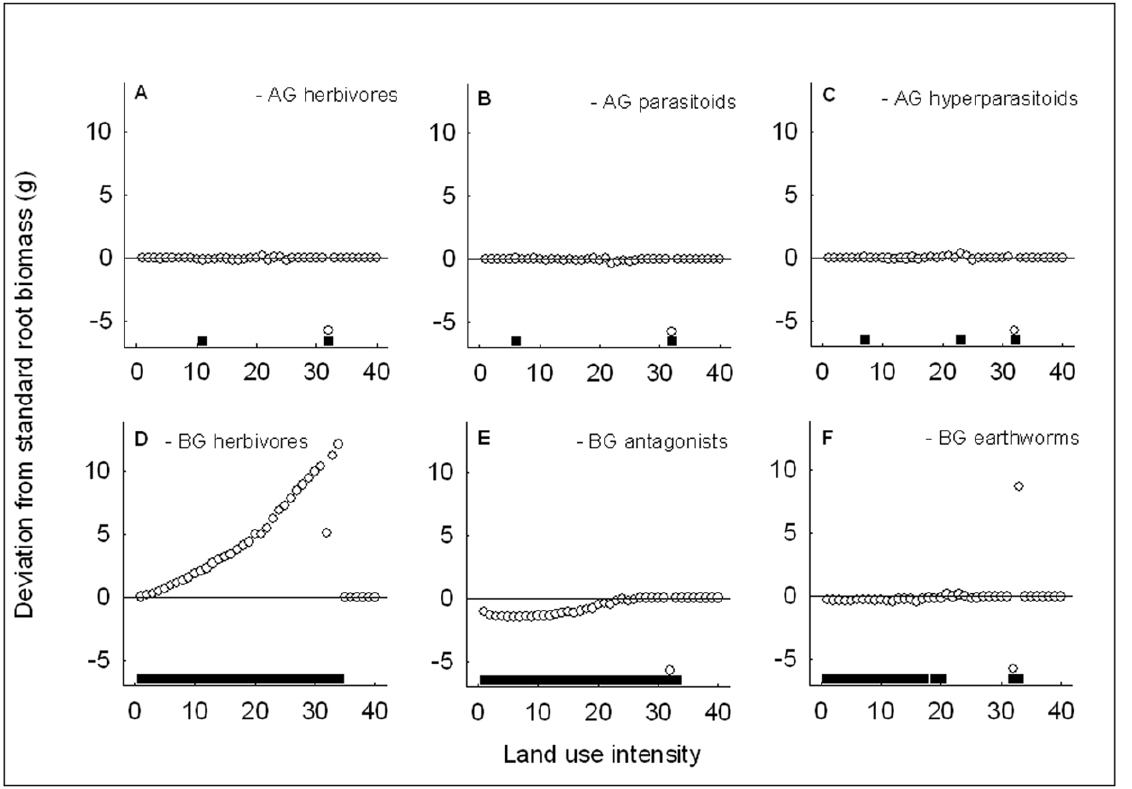
Figure 5. Root biomass and multitrophic interactions with increasing land use intensity. Deviation from median root biomass in the standard scenario from low to high land use intensity after removal of aboveground (top row) and belowground (bottom row) trophic levels and earthworms, i.e. removal of aboveground (a) herbivores, (b) parasitoids, or (c) hyperparasitoids, or belowground (d) herbivores, (e) antagonists, or (f) earthworms. AG – aboveground, BG – belowground. The horizontal line at 0.0 represents the values of the standard scenario. Points indicate the difference in root biomass between the respective removal scenario and standard scenario, and horizontal bars at the bottom of each graph indicate for each of the 40 points whether this difference is significant based on the Mann-Whitney U -test ( P , 0.05). Points above the 0.0-line show a positive effect of the removal of the respective trophic level on root biomass, points below the line a negative one. The horizontal bars show that belowground effects are dominating the effect on root biomass while aboveground effects are virtually